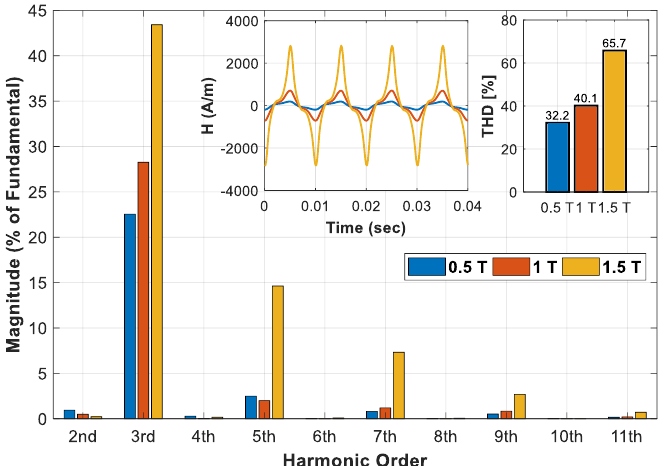
Figure 12. Spectrum of the magnetic field at different magnetic inductions.